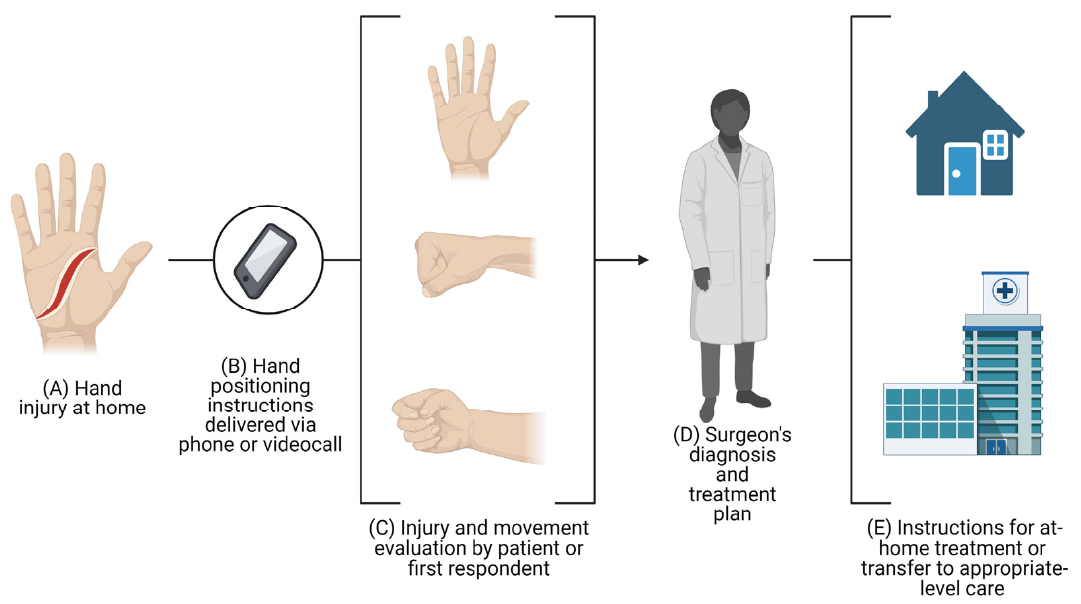
Figure 1. At-home hand injury evaluation. ( A ) With adequate standardization of hand injury photography, hand injuries could be evaluated on-site. ( B ) Patients could call the emergency services and receive specific hand positioning instructions to ( C ) perform their photo or video evaluation.